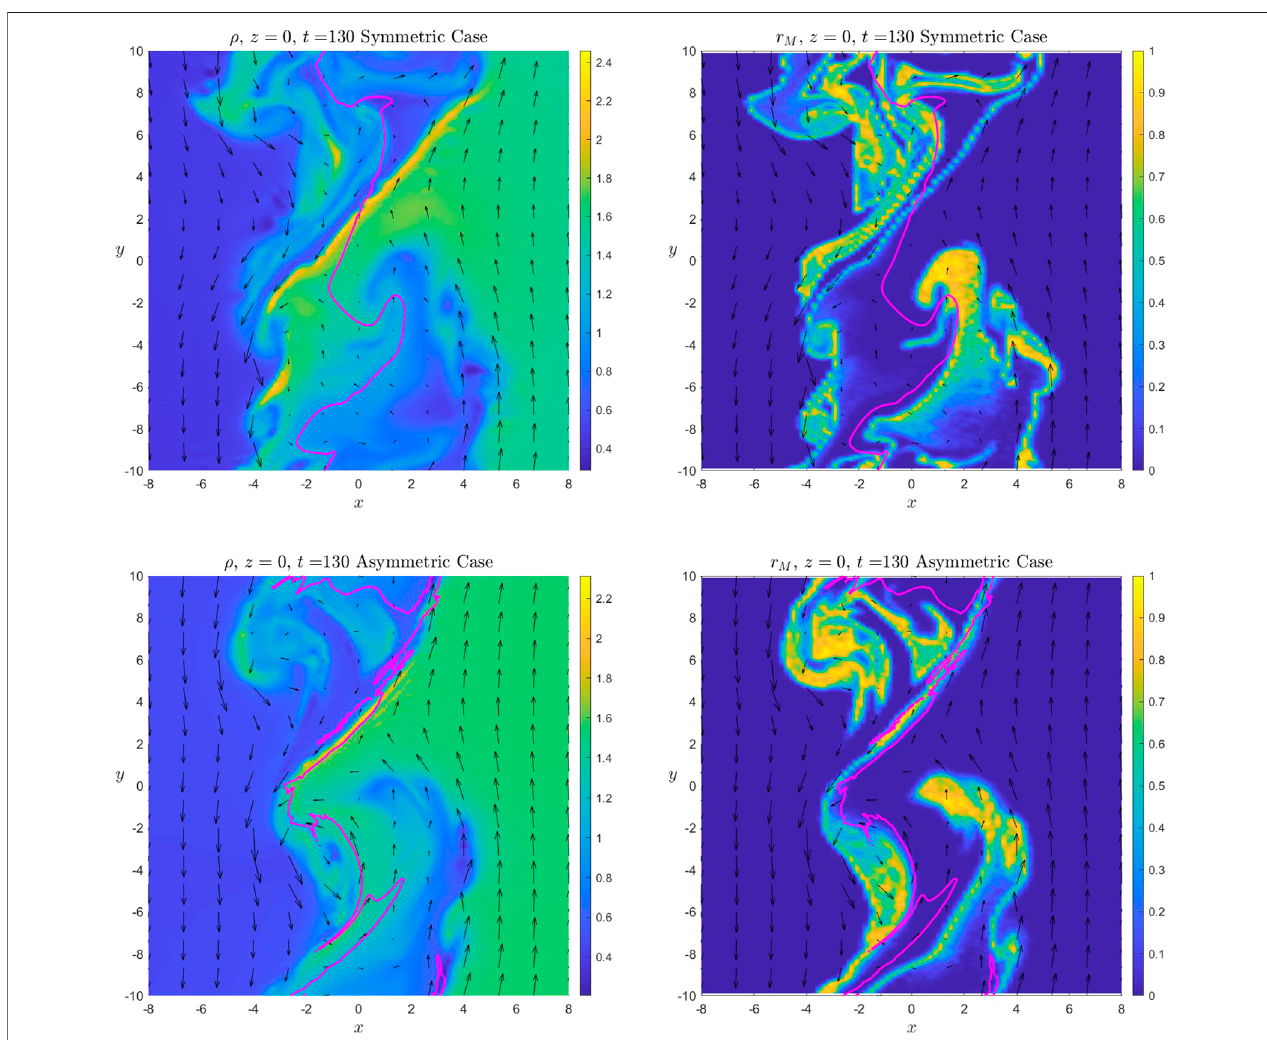
FIGURE 1 | A fully developed KH vortex in the equatorial plane ( z (cid:1) 0) at t (cid:1) 130 for the symmetric case (top) and the asymmetric case (bottom). The color index represents the plasma density (left) and mixing rate (right) . The black arrows represent the x and y components of the bulk velocity. The magenta line represents